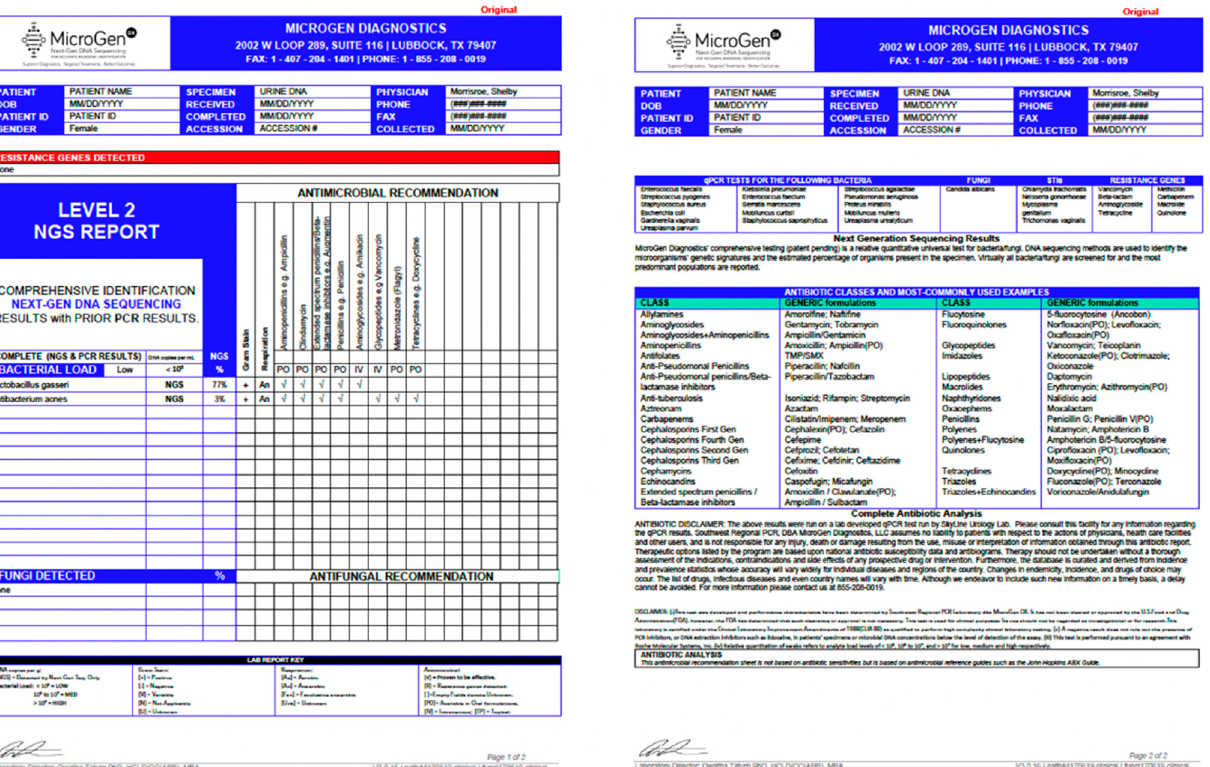
Figure 3. MicroGen DX Rapid Screening Results Sample Report.